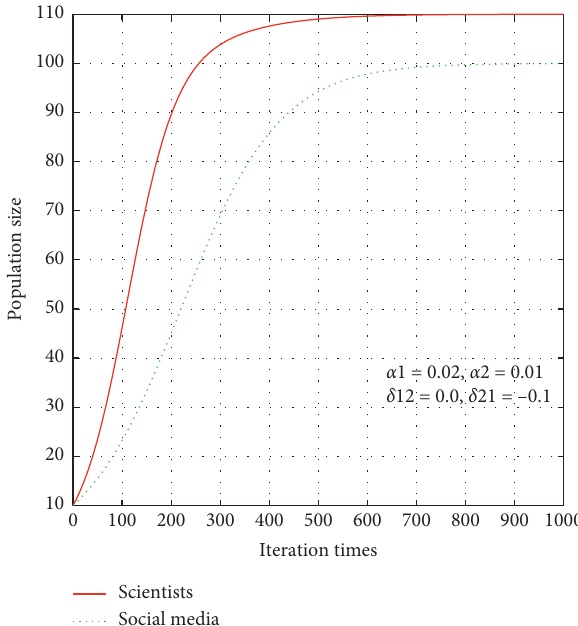
Figure 6: Commensalism pattern. Changes in the size of the two � 0 . 02, α � 0 . 01, 1 2 populations after 1000 iterations ( α � − 0 . and δ 21